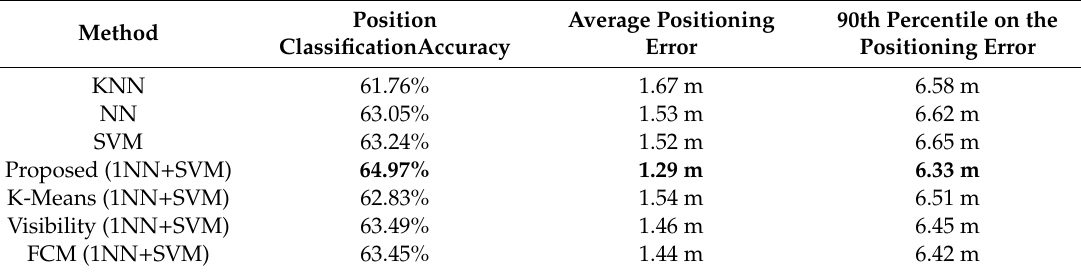
Table 2. Positioning performance comparison.